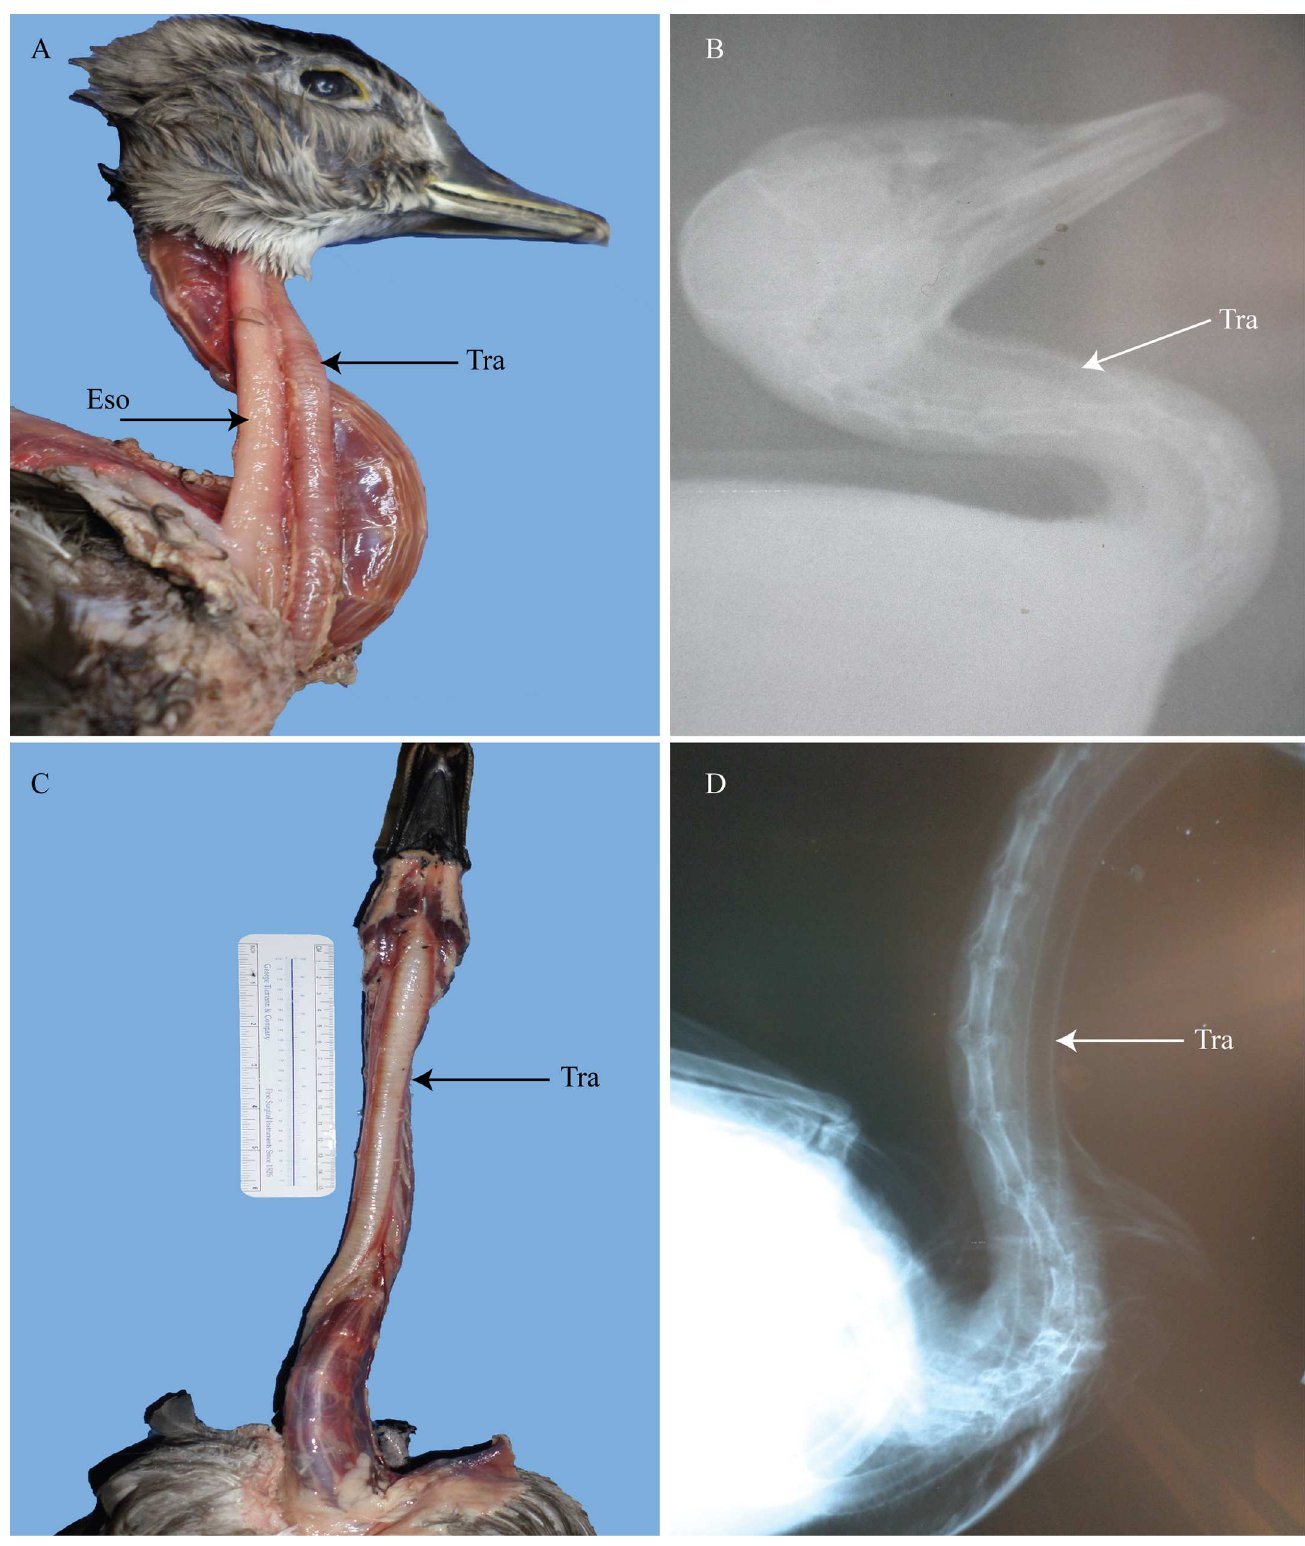
Fig 4. Duck and goosetracheaand esophagus. (A) rightlateralview of the neck of Aix sponsa showing displacement of the organs occurringquickly afterexiting the oropharynx.(B) radiograph of Aix sponsa .(C) ventral view of the neck of Brantacanadensis showing a gradual displacementof